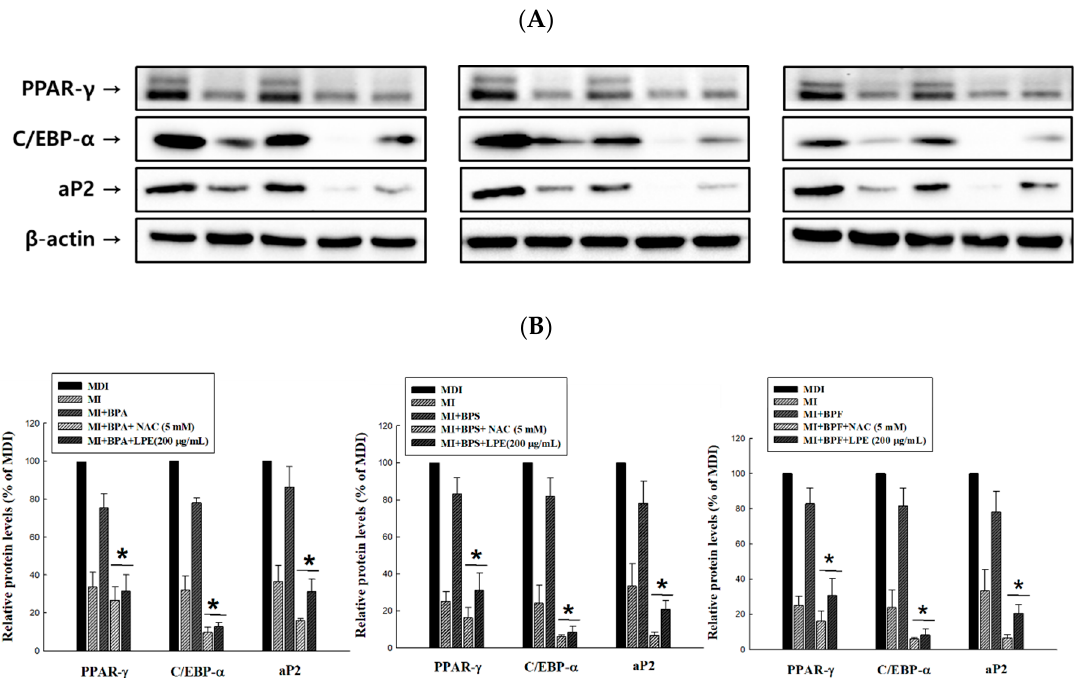
Figure 5. Effects of LPE on the protein expressions of BPA-, BPS-, and BPF-induced adipogenic transcription factors (PPAR- γ : 53, 57kDa, C/EBP- α : 42 kDa and aP2: 15kDa) in 3T3-L1 adipocytes. ( A ) Total protein was obtained using a lysis buffer and quantified by loading, transfer, blocking, and appropriate antibody reactions. ( B ) Expression levels of adipogenic transcription factors were densitometrically normalized to those of β -actin and compared to the MDI control group as a percentage in each antibody. All values are presented as the mean ± SD. * p < 0.05 VS. BPA, BPS, or BPF treatment group, according to one-way analysis of variance.